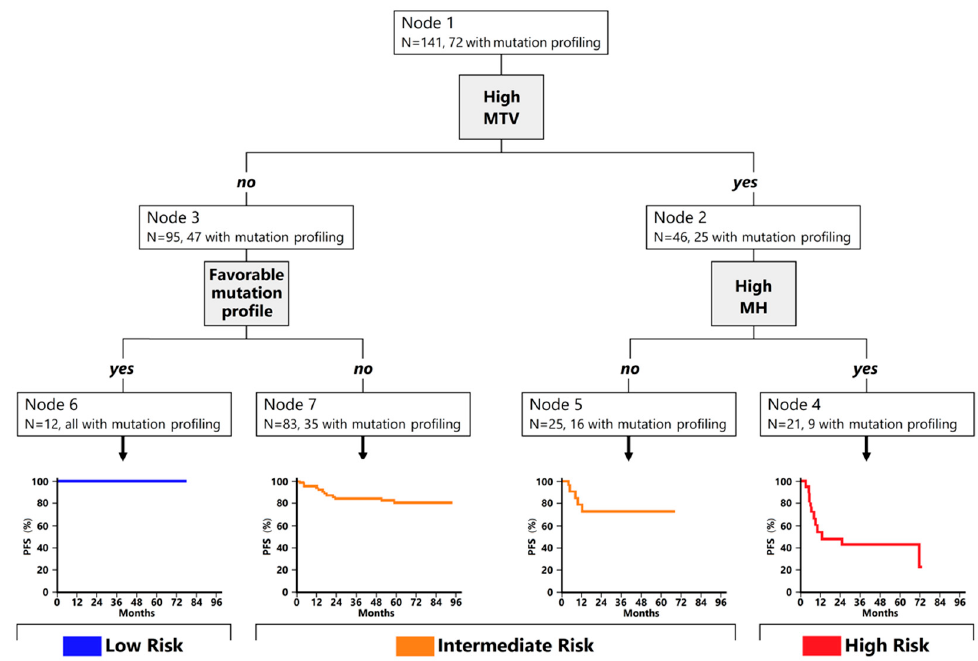
Figure 2. Classification tree analysis for PFS prediction. Node 1: A total of 141 patients were included for the current analysis. Patients with high MTV were sorted in node 2 (N = 46). Node 2 was then sorted based on MH. Patients with MTV and MH high were clustered into node 4 (N = 21), while patients with MTV high and MH low were clustered in node 5 (N = 25). Patients with low MTV (node 3; N = 95) were then evaluated for the presence of a known favorable mutational profile. Patients with favorable mutational profiles and low MTV were classified in node 6 (N = 12). Patients with low MTV and without a known favorable mutational profile constituted node 7 (N = 83). Node 4 was defined as high-risk group, while node 6 was defined as low-risk group. Nodes 5 and 7 were then merged in a single group, referred to as intermediate-risk group.